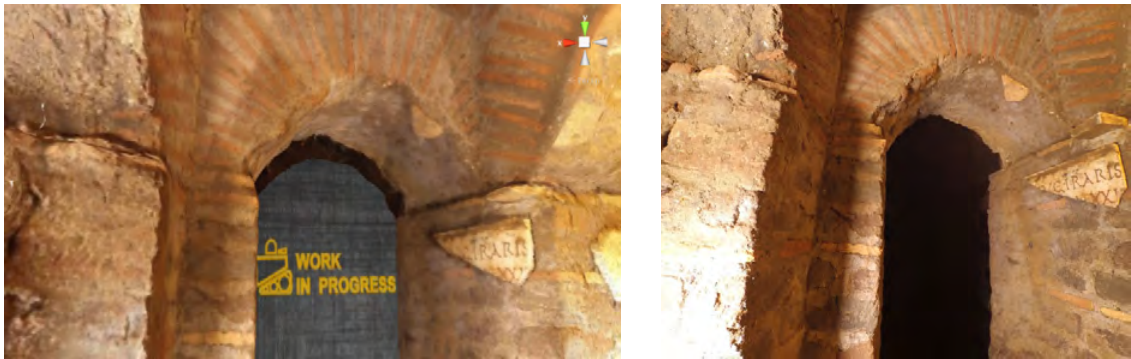
Figure 5. (Left picture) navigation through the Catacombs of Priscilla 3D virtual reconstruction made during ROVINA; (right picture) photos of the same area inside the real